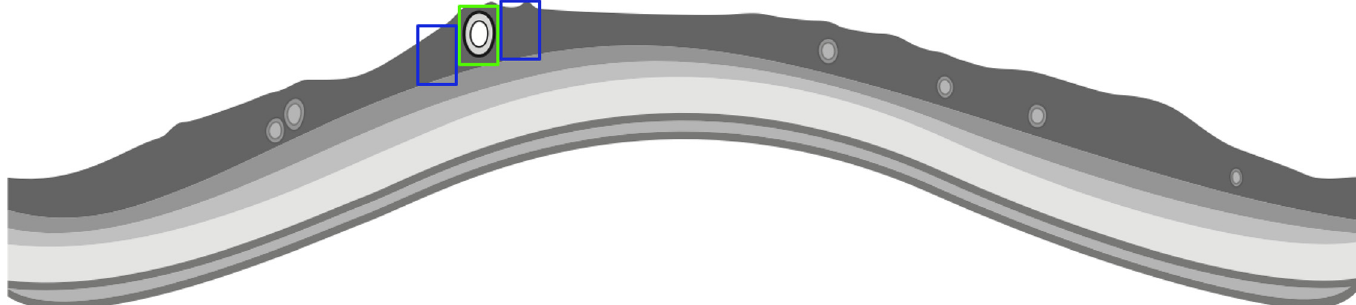
Fig 1. Schematic illustration of the SD-OCT-based analysis. The approaching light is reflected and scattered by the vessels. The hypothesis is that the characteristics of the change in contrast resemble the vessel morphology. In this image the simplified calculation of the change in grey value is achieved by comparing the mean grey value of the blue boxes with that of the green